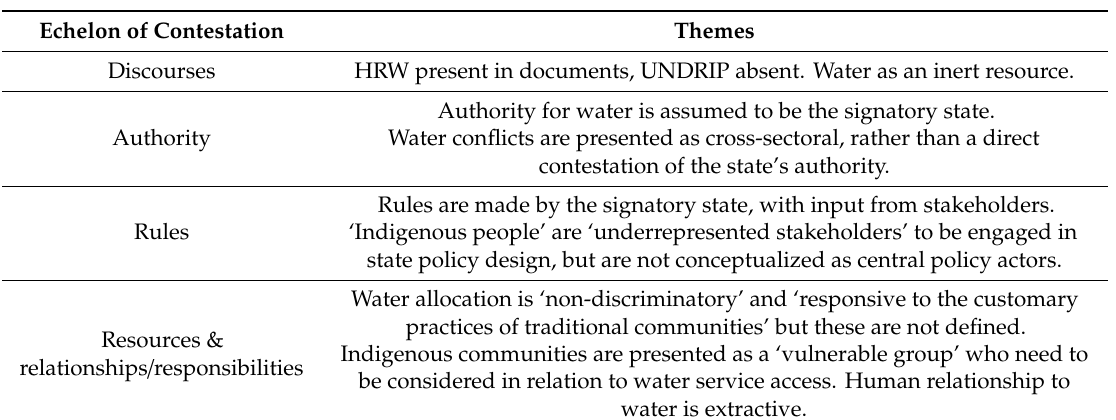
Table 2. Water contestation themes in the reviewed documents about the OECD Principles. Echelon of Contestation